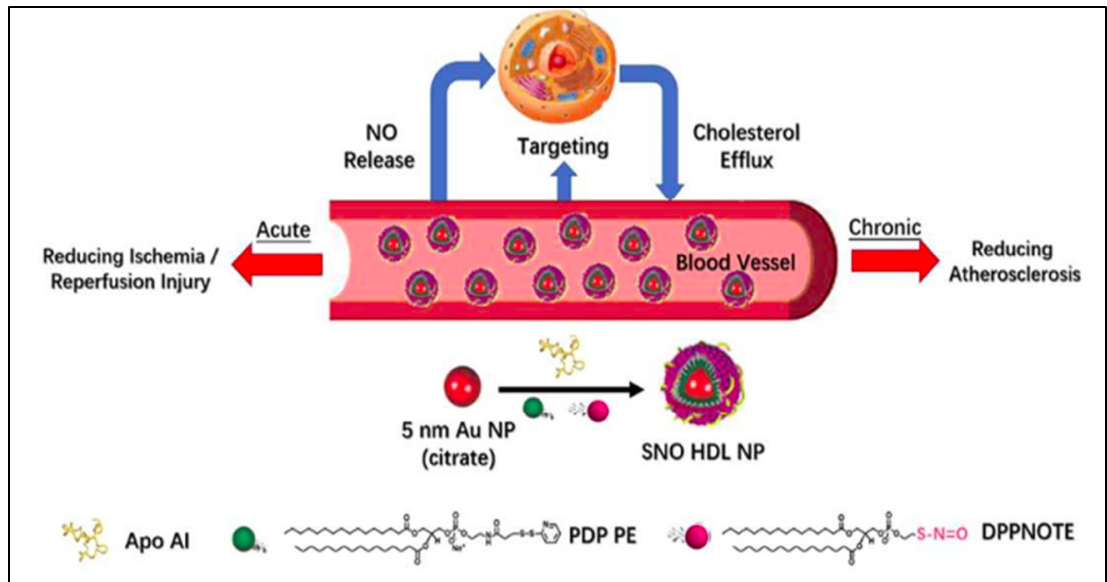
Figure 3. HDL-like NPs as a biomimetic nanotherapy for CVDs. Reprinted with permission from [78] Copyright 2018, American Chemical Society.